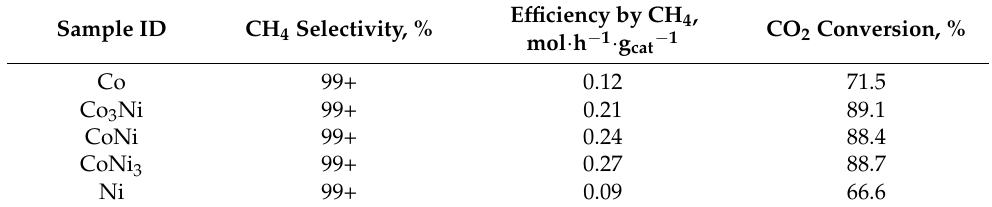
Table 2. Catalytic performance of the CO 2 hydrogenation reaction, for the Co, Co 3 Ni, CoNi, CoNi 3 , and Ni catalysts (calculated at T = 300 ◦ C, P = 2 MPa, H 2 :CO 2 = 4:1, VHSV = 4500 mL · g − 1 h − 1 ). Sample ID